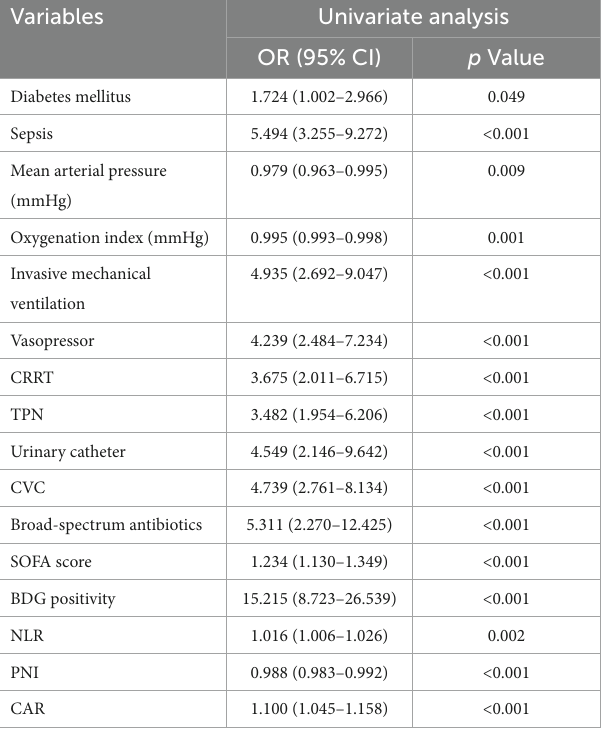
TABLE 2 Univariate analysis for IC-associated risk factors in the development